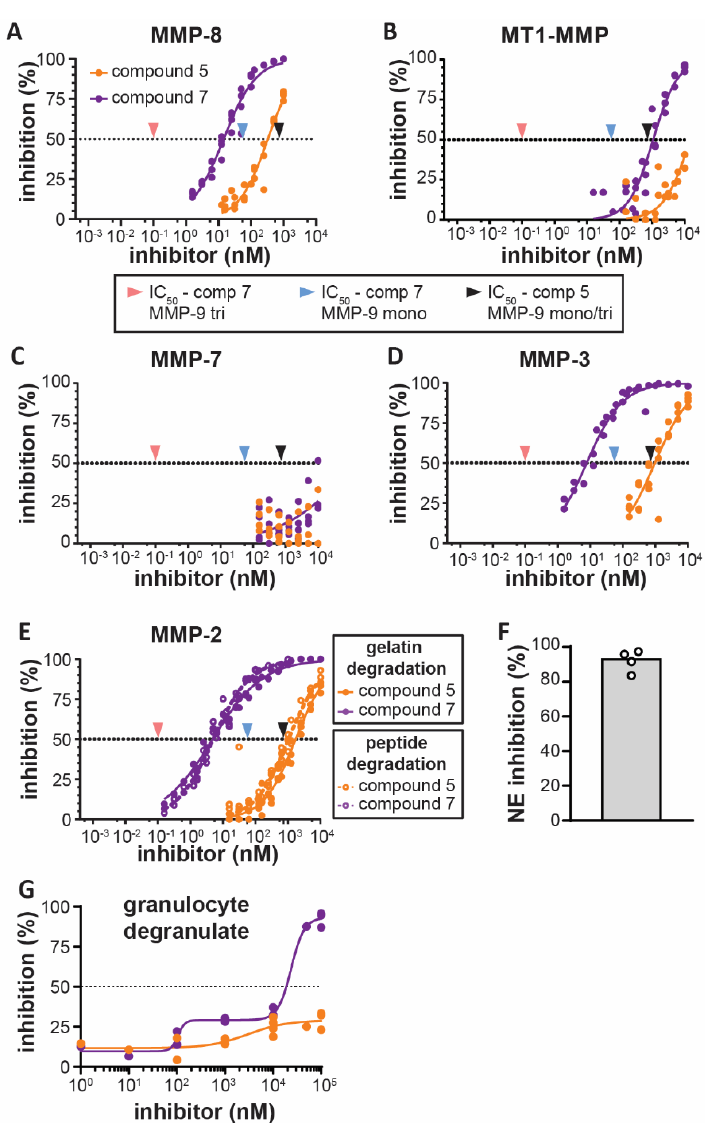
Figure 2. Inhibition of other proteases by monovalent and bivalent carboxylate inhibitors. ( A ) Inhibition of proteolytic activity of MMP-8 by the monovalent inhibitor (orange) and bivalent inhibitor (purple). Arrows indicate the IC 50 -values for the inhibition of MMP-9 trimers by the bivalent inhibitor (red), inhibition of MMP-9 monomers by the bivalent inhibitor (blue) and inhibition of MMP-9 monomers and trimers with the monovalent inhibitor (black); ( B ) inhibition of proteolytic activity of membrane-type-1-MMP (MT1-MMP)/MMP-14 by the monovalent inhibitor (orange) and bivalent inhibitor (purple); ( C ) inhibition of proteolytic activity of MMP-7 by the monovalent inhibitor (orange) and bivalent inhibitor (purple); ( D ) inhibition of proteolytic activity of MMP-3 by the monovalent inhibitor (orange) and bivalent inhibitor (purple); ( E ) inhibition of proteolytic activity of MMP-2 by the monovalent inhibitor (orange) and bivalent inhibitor (purple), as tested with a fluorogenic gelatin substrate (closed circles) and a fluorogenic peptide substrate (open circles); ( F ) percentage of gelatinolytic activity in the secretions of fMLF stimulated human granulocytes inhibited by a neutrophil elastase inhibitor (20 µM). Granulocyte secretions from four different blood donors were analyzed ( n = 4). Each data point is indicated by a circle; ( G ) inhibition of non-neutrophil elastase-derived gelatinolytic activity in secretions of fMLF stimulated human granulocytes by compound 5 (orange) and compound 7 (purple). Data were fitted with a dose-response curve and all tests were done in the presence of 20 µM neutrophil elastase inhibitor. Each data point represents a different blood donor ( n = 4).